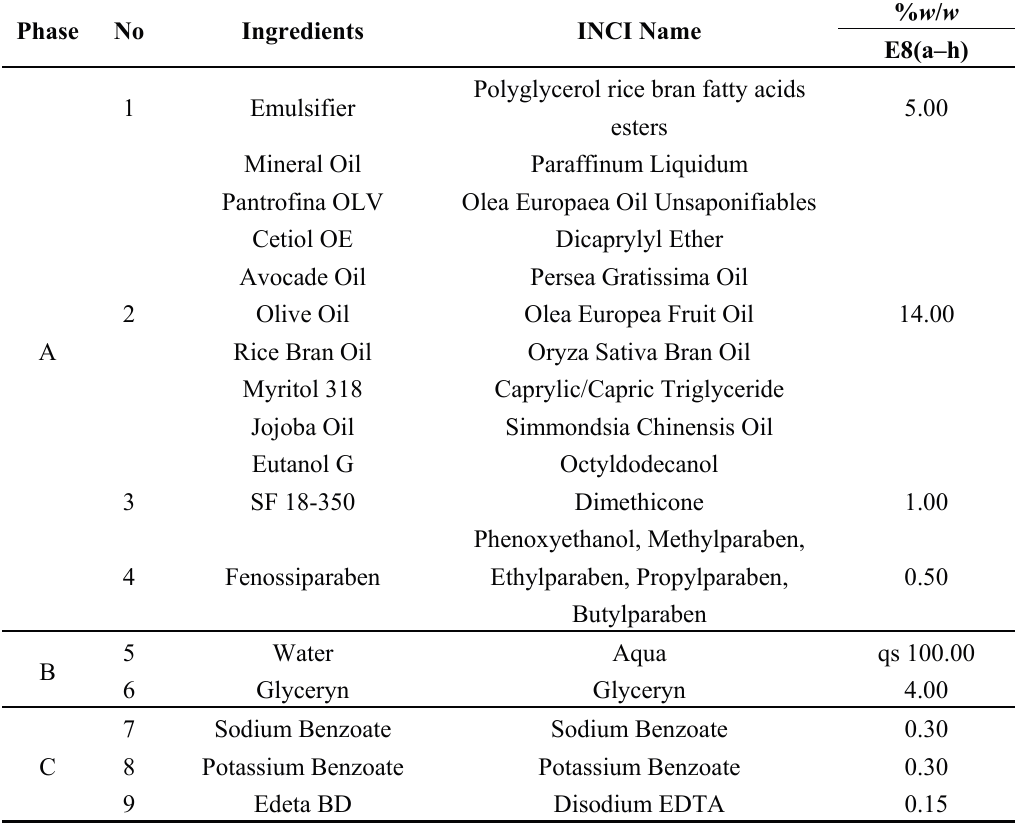
Table 3. Composition of O/W basic emulsions containing oils with different polarity.